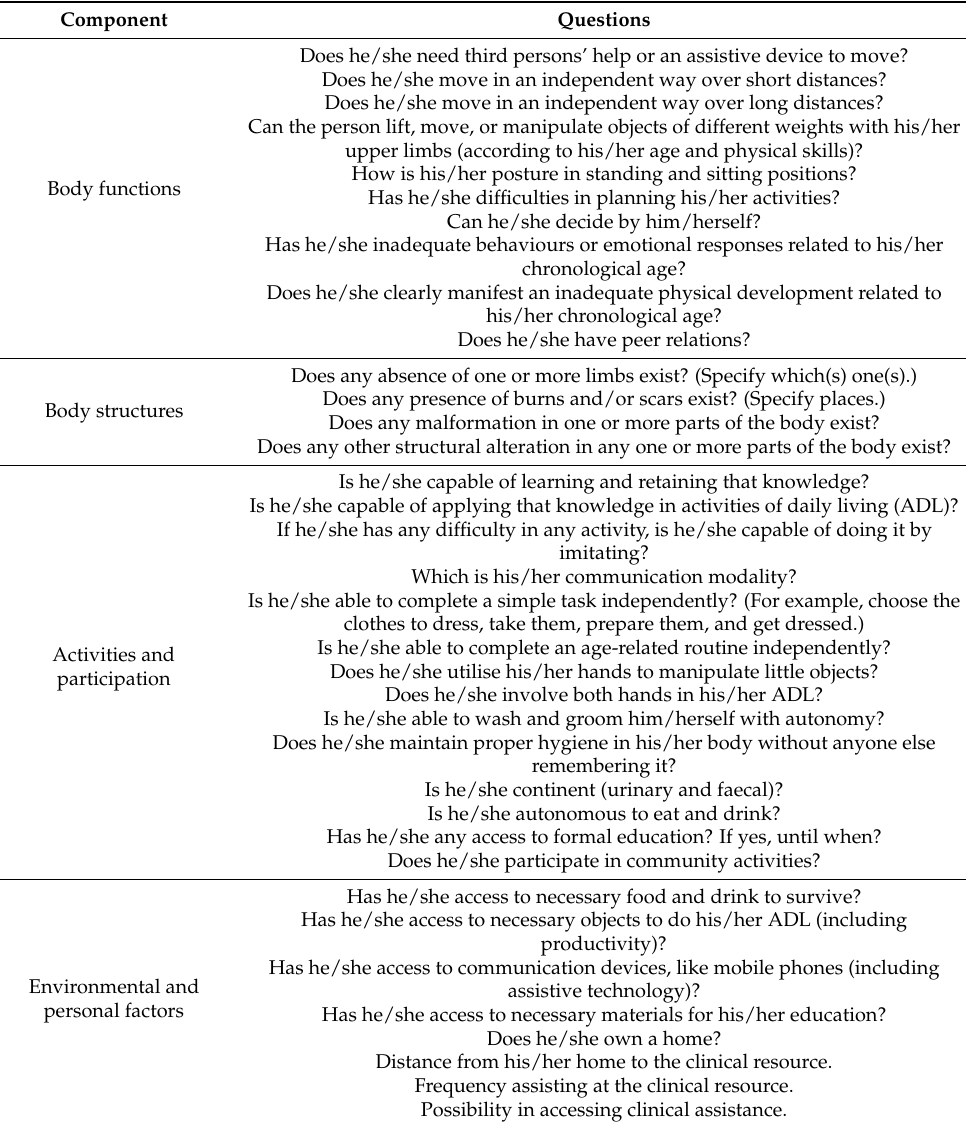
Table 1. Questions for the initial screening, related to the created